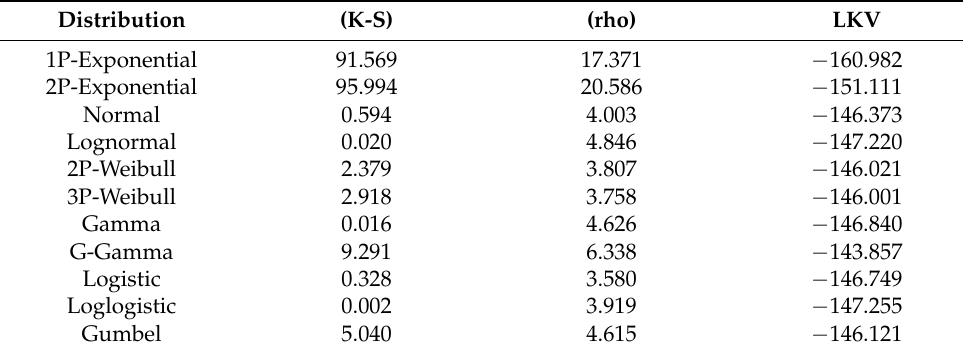
Table 3. Values of factors for estate body type.